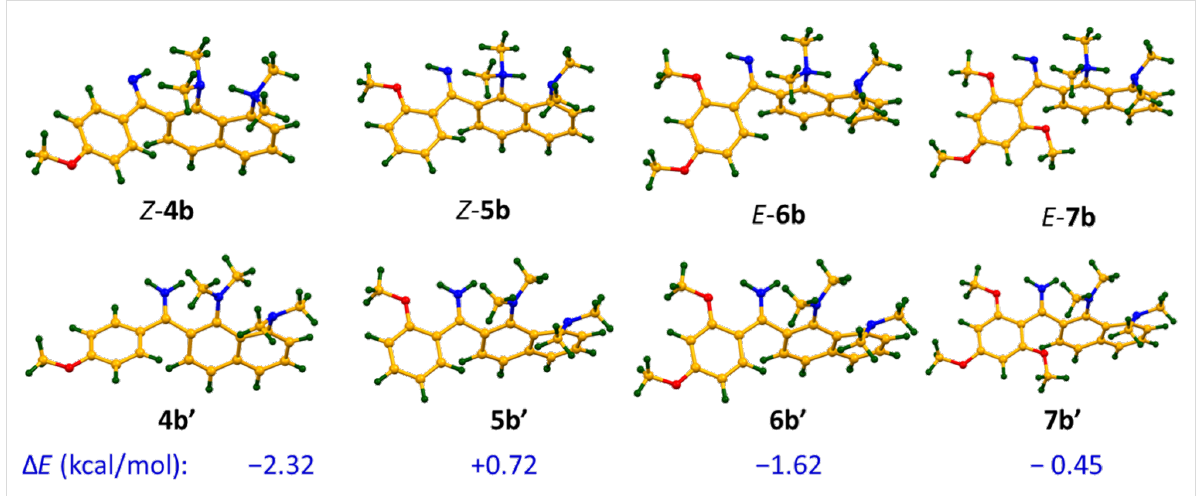
Figure 5: Optimised geometries and energy differences Δ E = E b’ – E b (kcal/mol) for different sites of protonation of the studied imines (B3LYP/6- 311+G(d,p)).